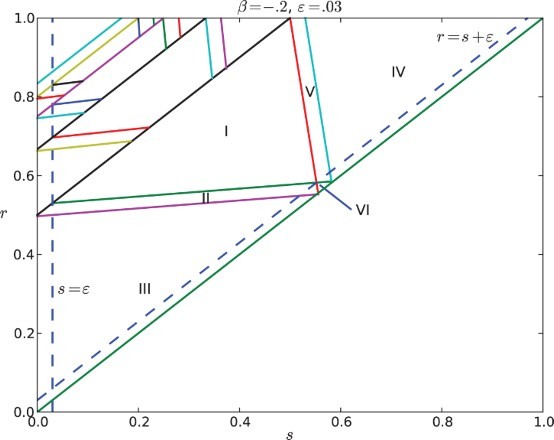
Regions of parameter space for the k cyclic solutions with k=M+1. Here the feedback is negative with β=−.2 and the gap is ε=0.03. The widest diagonal band contains the parameters for k=2 and is partitioned into six cases. Note that case VI disobeys the constraint ε<r−s. The rest of the diagonal bands contain parameters for k=3, 4, … and each of them is partitioned into five cases.